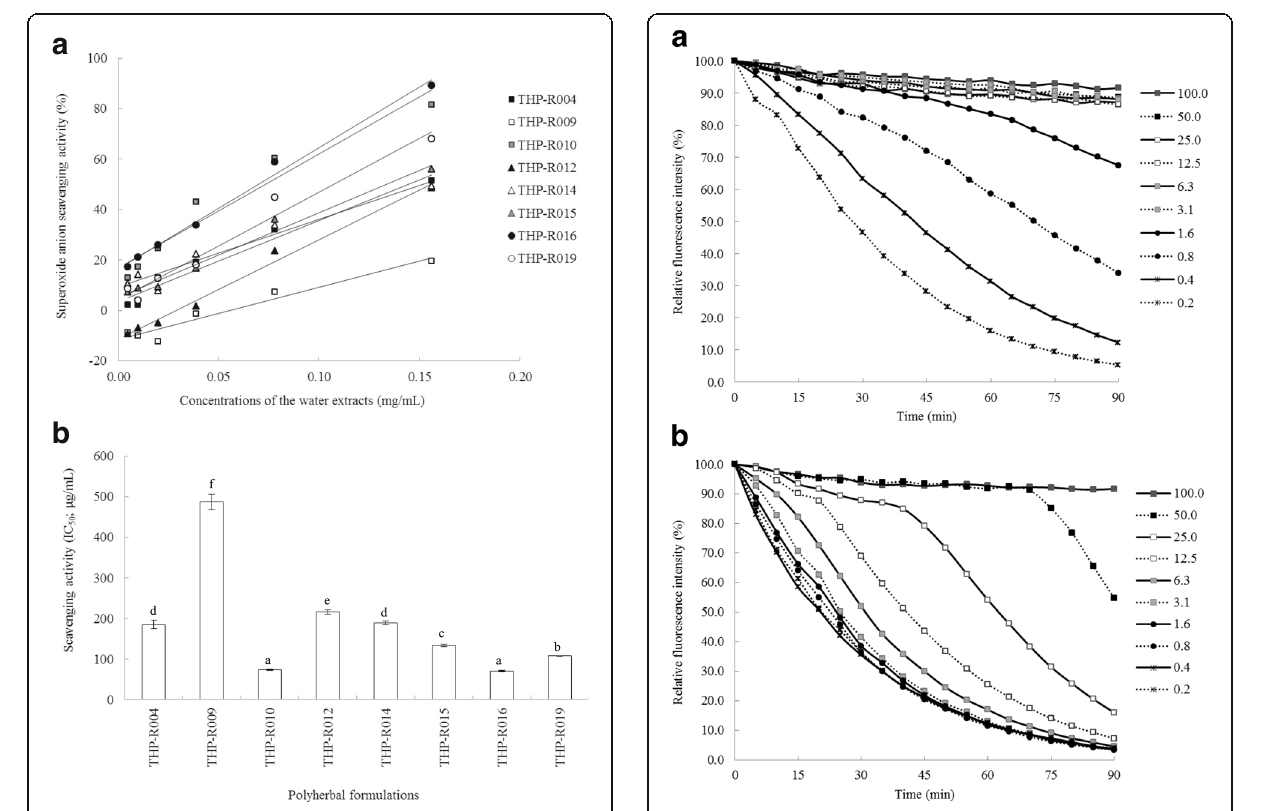
Fig. 2 Superoxide anion scavenging activity of water extracts prepared from Thai traditional polyherbal formulations. The water extracts inhibited superoxide anion production in a dose-dependent manner ( a ). The IC 50 values (50% inhibitory concentration) are expressed as the mean ± SD ( b ). The IC 50 value of catechin, a positive control, was 9.1 ± 0.3 μ g/mL. Different letters indicate statistically significant differences ( p < 0.01)